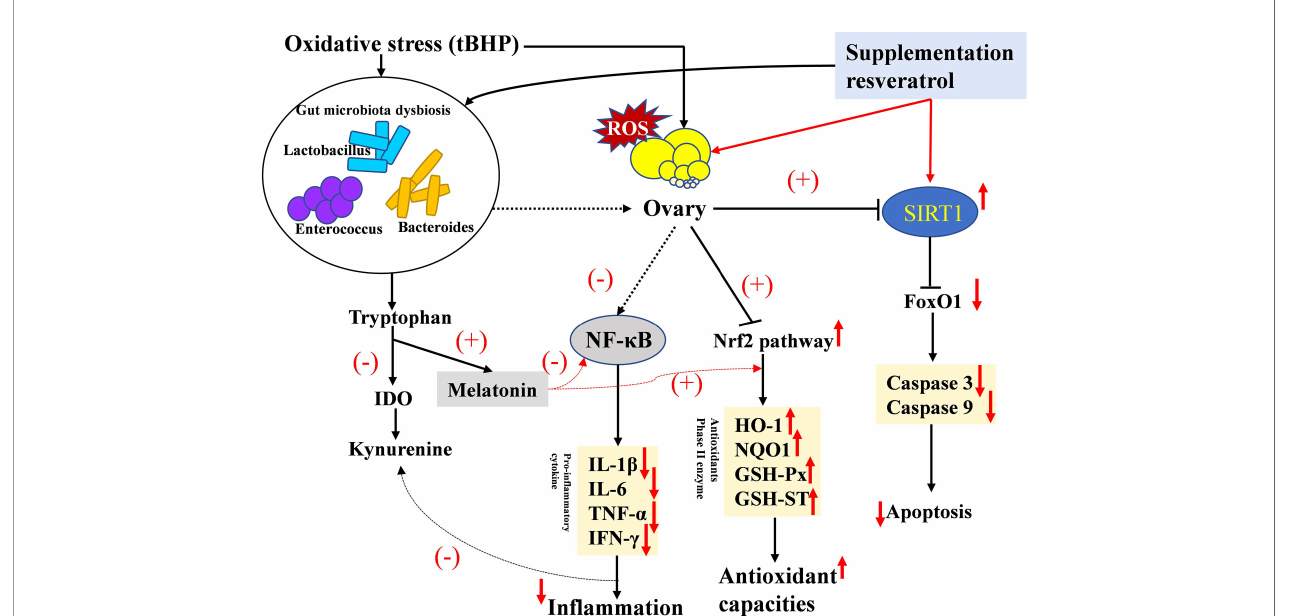
FIGURE 10 | Graphical abstract of this article. Proposed mechanism of oxidative stress in lowering ovary function and the ameliorating effect of melatonin in the layer model. The up arrow ( ↑ ,+) and down arrow ( ↓ ,-) represent upregulation and downregulation effects of oxidative stress and resveratrol,